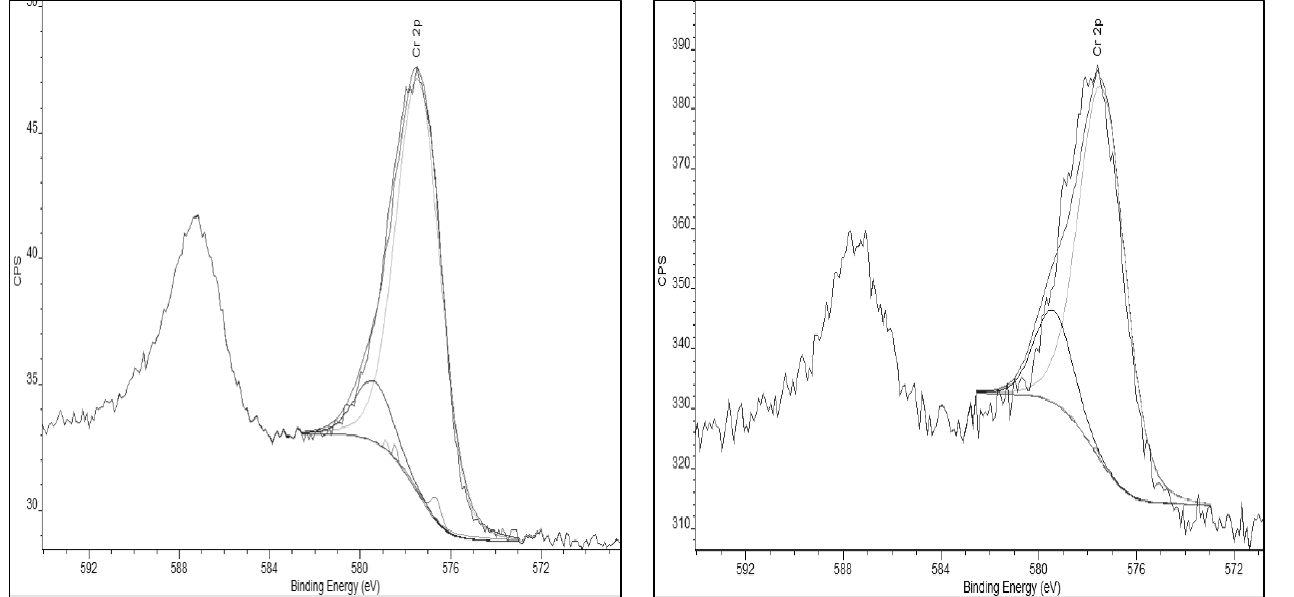
Figure 5. ( Left ) Cr2p peak of Standard Activated Carbon, post-chromium adsorption. ( Right ) Cr2p peak of the Thermally-Treated Activated Carbon post-chromium adsorption.